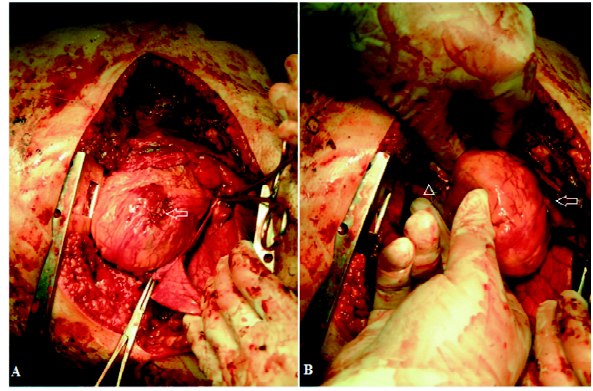
Fig. 1 - A: Orifício de entrada próximo à artéria coronária descendente anterior (seta); B: orifício de saída próximo à artéria coronária direita (ponta de seta)